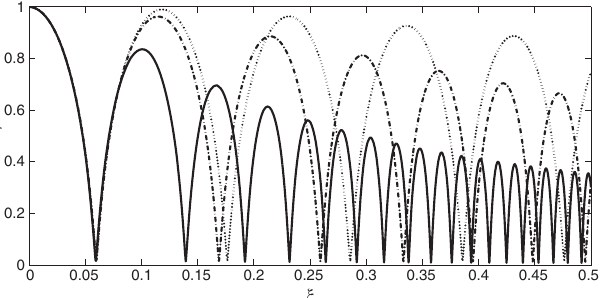
FIG. 4. Comparing the dimensionless beamwidth parameter with the dimensionless propagation distance for one Rayleigh length and in conditions of Fig. 1 for the thermal quantum plasma (dotted), the cold quantum plasma (dashed) and the classical plasma (solid), with B ¼ 2 .